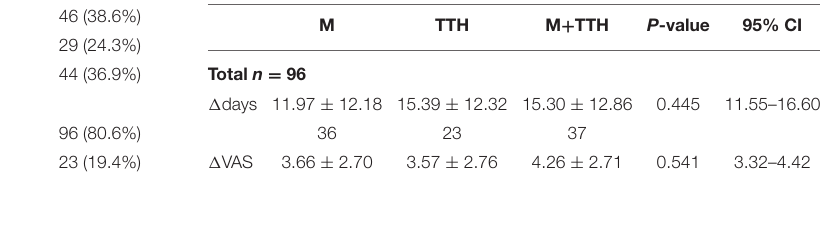
TABLE 3 | Intensity and frequency of headaches divided by headache subtypes with changes in the frequency ( 1 days) and intensity of headaches ( 1 VAS) in group of surgical intervention after a long-term follow-up.